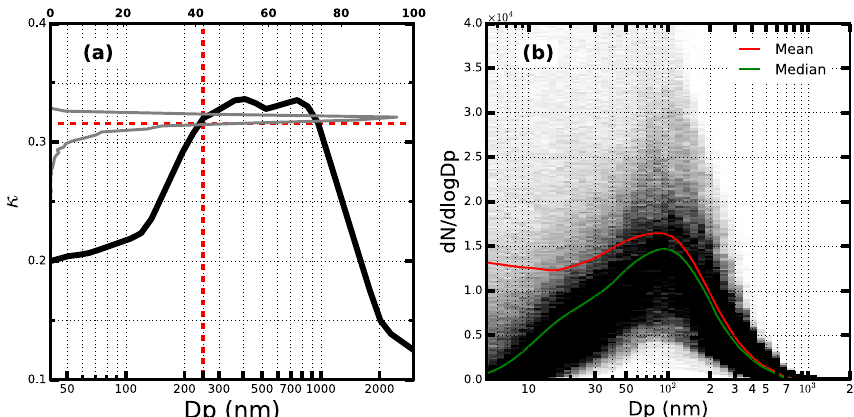
Figure 3. (a) The thick black line represents the average size-resolved κ distribution from the HaChi campaign. The solid gray line represents the probability distribution of retrieved κ values with this size-resolved κ distribution by using all PNSDs shown in (b) , and the horizontal dashed line represents their average. The vertical dashed red line represents the position of 250nm. (b) All PNSDs that are observed from three different representative background sites of the NCP during summer; they are used to model the relationship between size-resolved κ and retrieved κ values from f ( RH ) measurements, and the gray color represents the frequency of PNSD. Darker points correspond to a higher frequency. The red and green lines represent the mean of median values of all observed PNSDs.